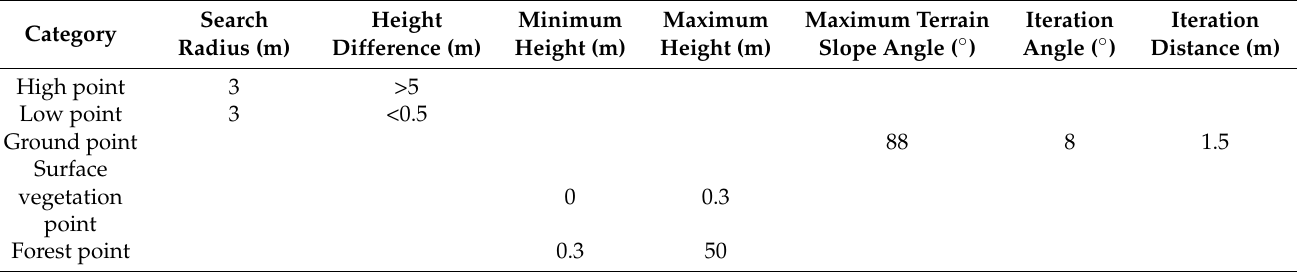
Table 3. Height threshold parameters of classification and